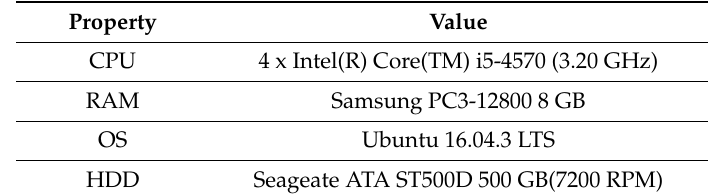
Table 2. Detailed properties of experimental environment.